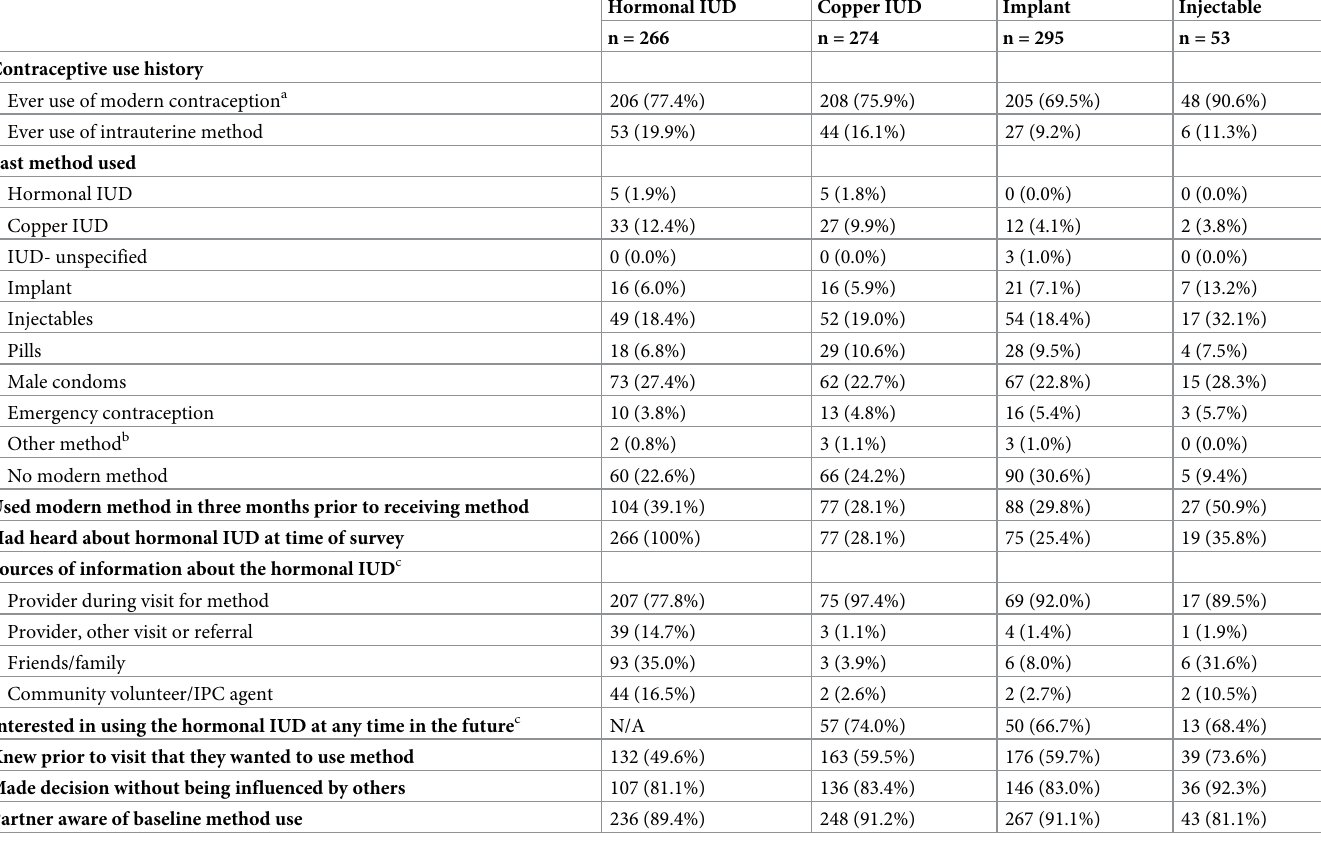
Table 2. Contraceptive use history and decision